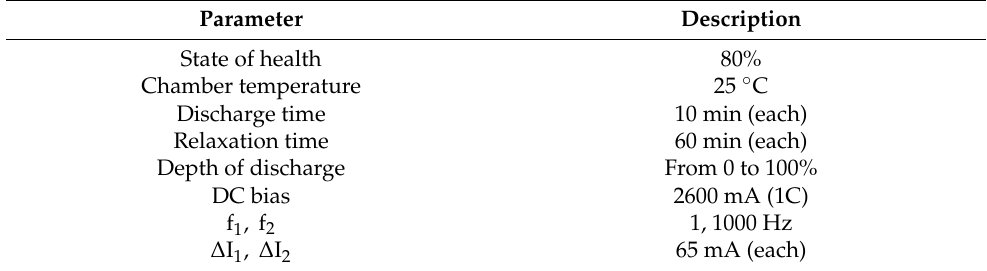
Table 5. Experimental conditions for SoC estimation of cells that start operating at different